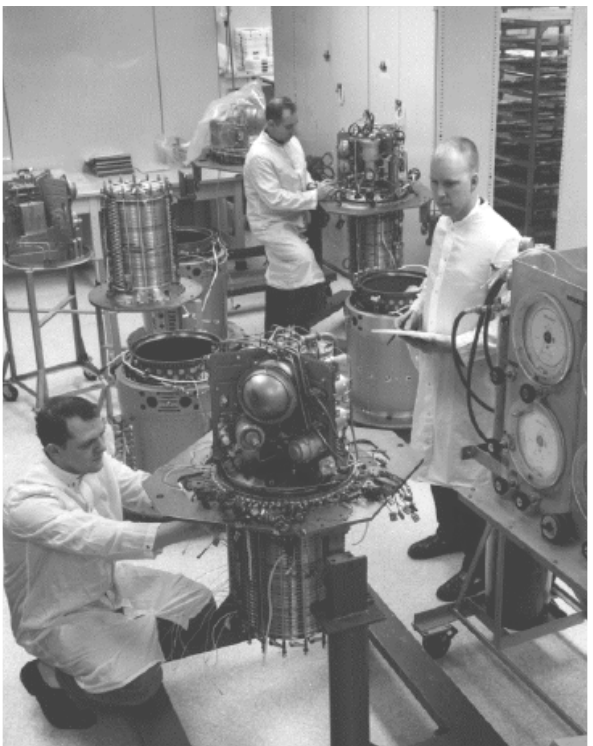
Figure 10. Apollo fuel cell assembly at Pratt & Whitney. From the Science Service Historical Images Collection, courtesy Pratt & Whitney.